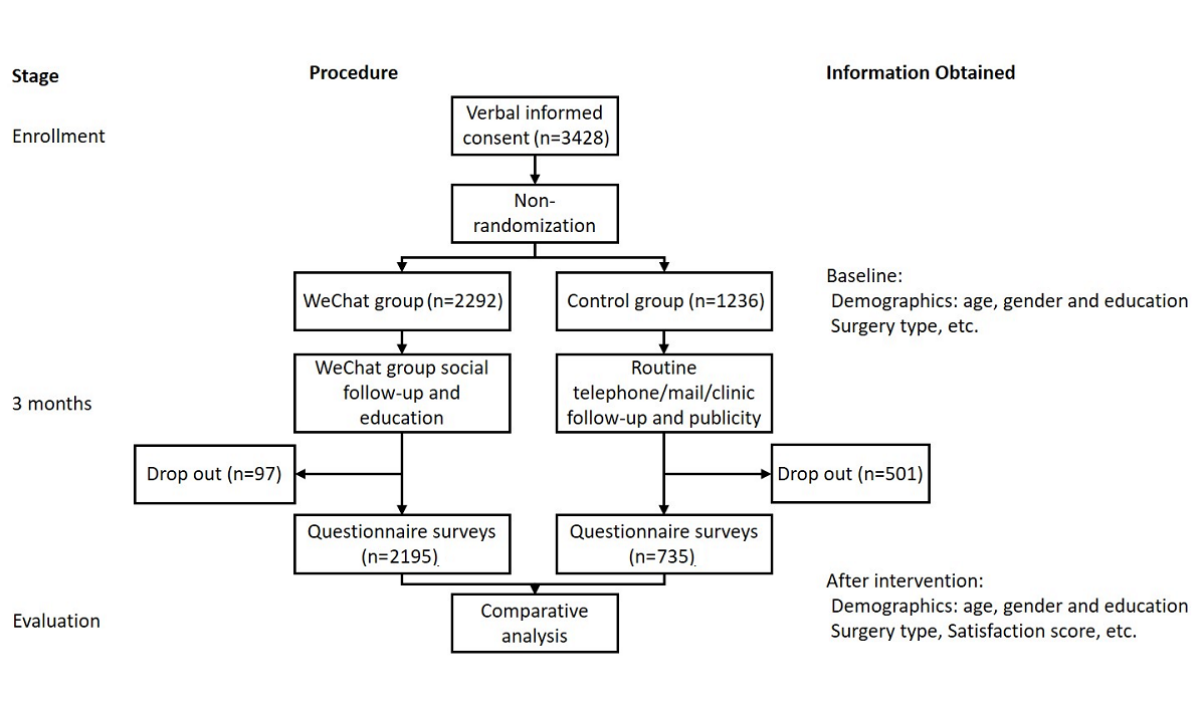
Figure 2. Flowchart of